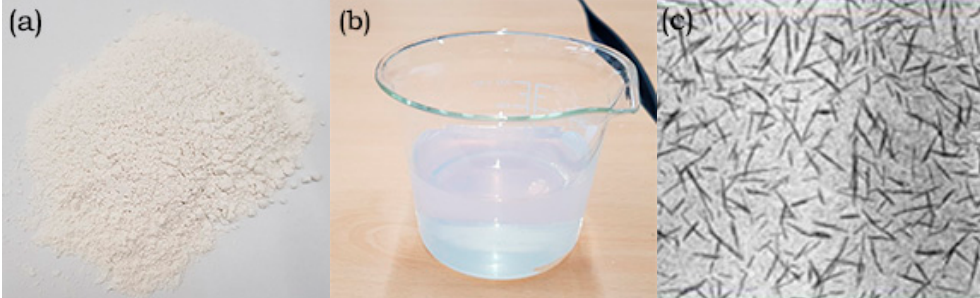
Figure 1. CNCs before and after dispersion & TEM analysis. ( a ) Powder-type CNCs, ( b ) suspension